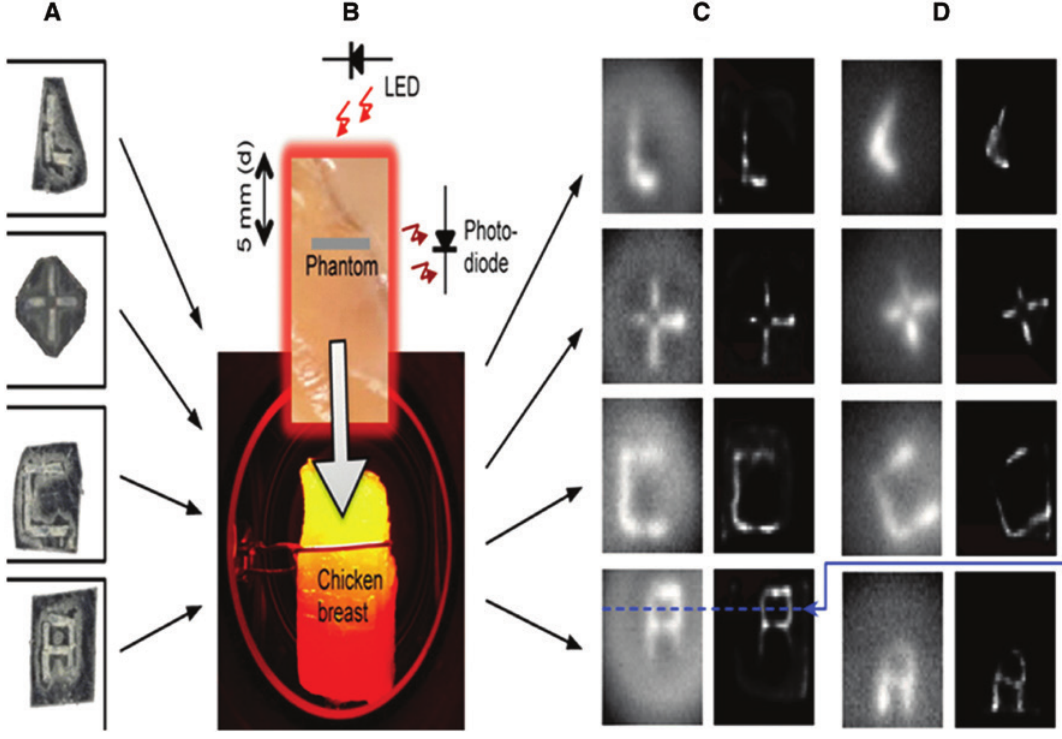
Figure 16: Nanodiamonds in high contrast molecular imaging. (A) Nanodiamond phantoms (with different patterns) made of double-sticky tape. (B) The gray stripe on the piece of chicken breast represents the edge of the phantom, which is placed inside the chicken breast, 5 mm back from the front surface, facing the LED. Fluorescence is collected off to the side. Also shown is the actual piece of chicken breast illuminated by the LED. (C) The phantoms imaged outside of the chicken breast, both before (left) and after (right) deconvolution by the point-spread function. (D) Same as (C) but under a 5-mm chicken breast. Adapted from